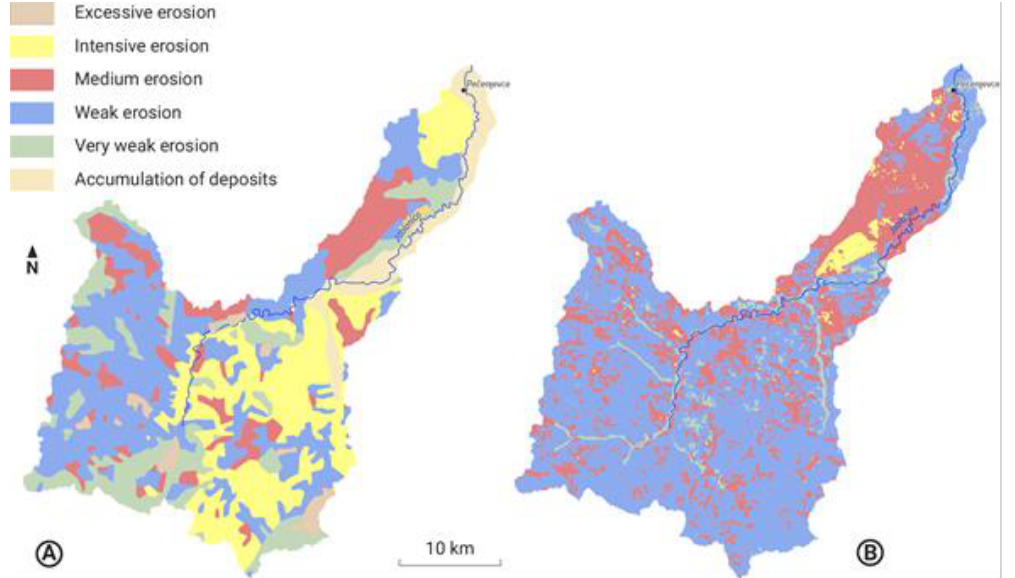
Figure 2. Soil Erosion Map of the Jablanica River Basin in 1971 ( A ) and 2016 ( B ).